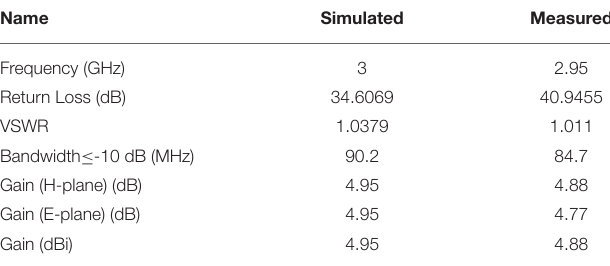
TABLE 3 | Simulation and measurement results of the proposed antenna with four-line